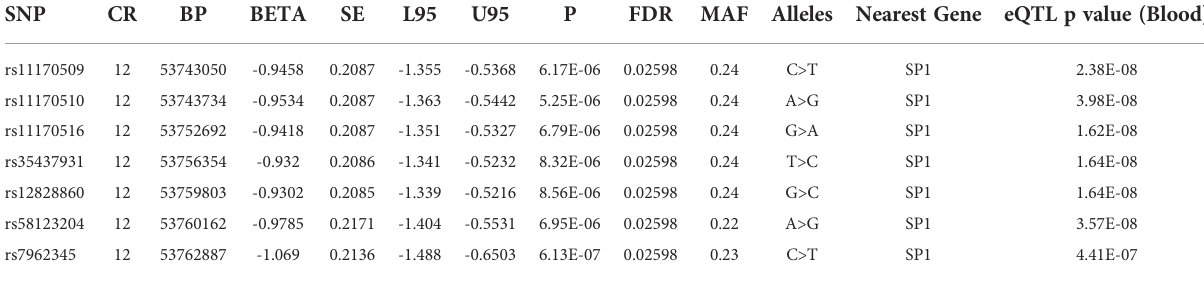
TABLE 1 Signi fi cant genetic loci associated with cold sensitivity. SNP CR BP